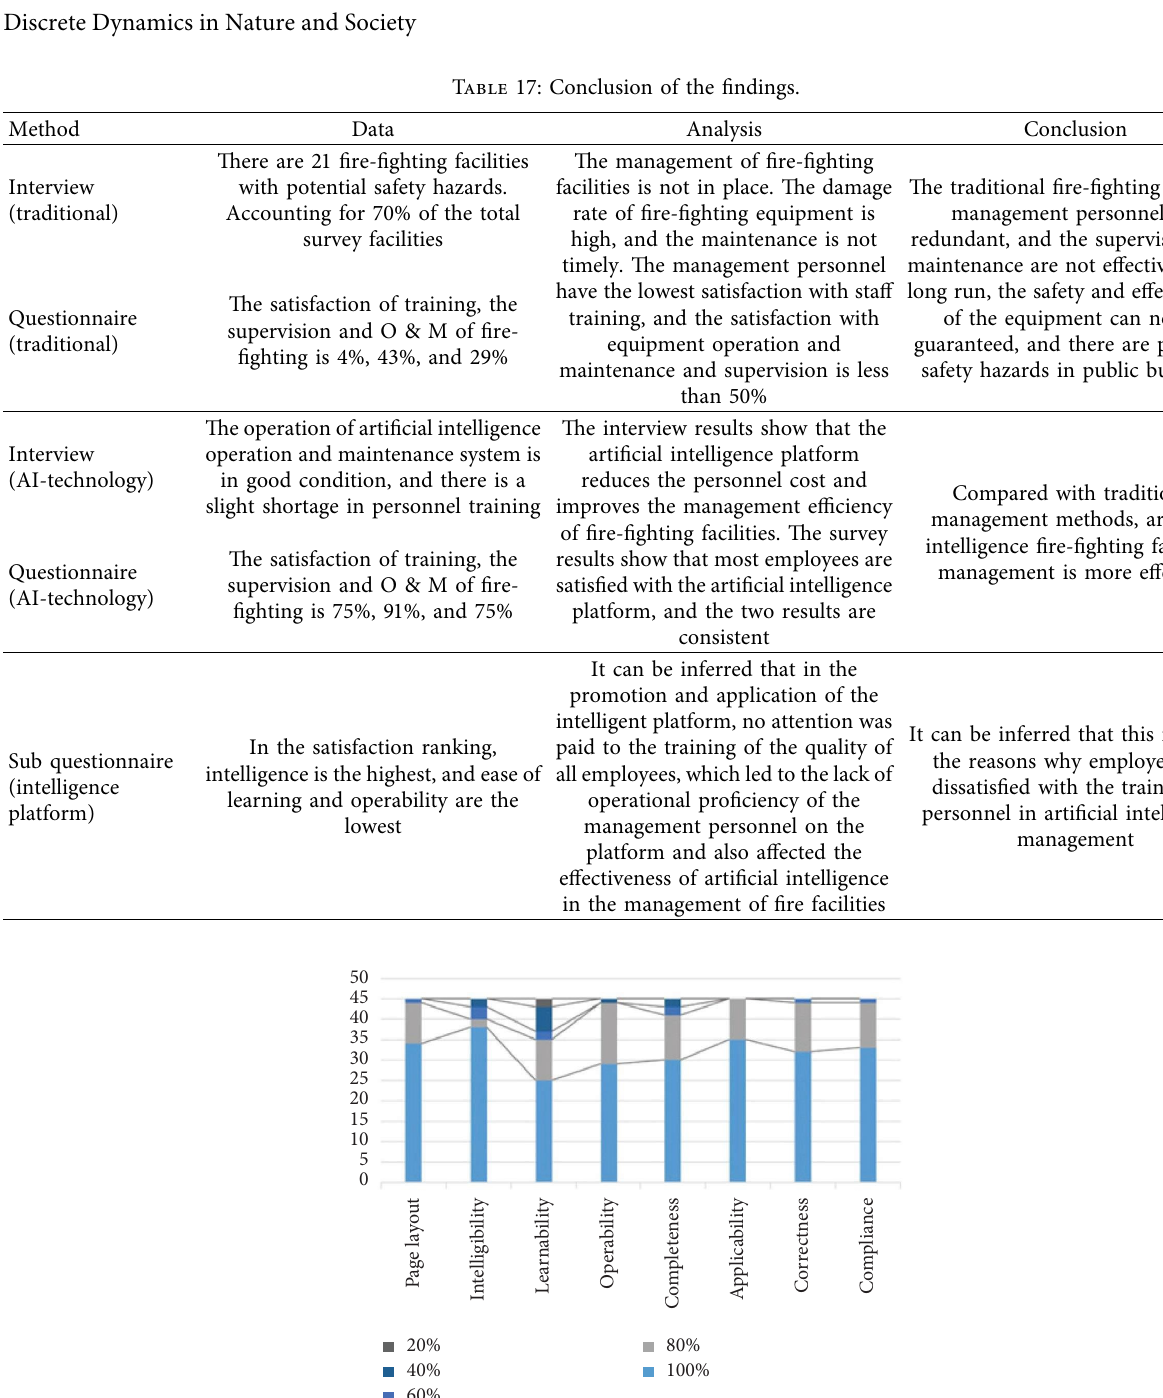
Figure 8: Data from the questionnaire of satisfaction feedback of the intelligence